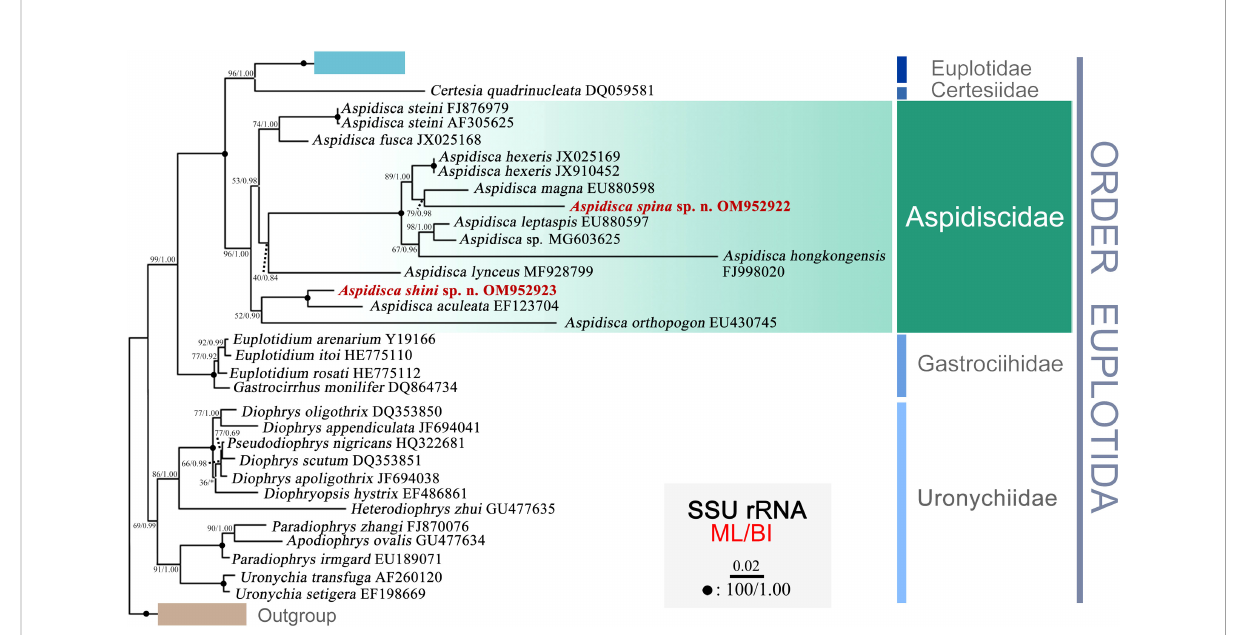
FIGURE 6 Phylogenetic tree inferred from SSU rRNA gene sequences, using maximum likelihood (ML) and Bayesian inference (BI) methods. Sequences of the new described species are highlighted in bold and red. Bootstrap support for ML tree and posterior probability for BI tree are given near nodes. Fully supported (100/1.00) branches are marked with solid circles. The scale bar represents two substitutions per 100 nucleotide